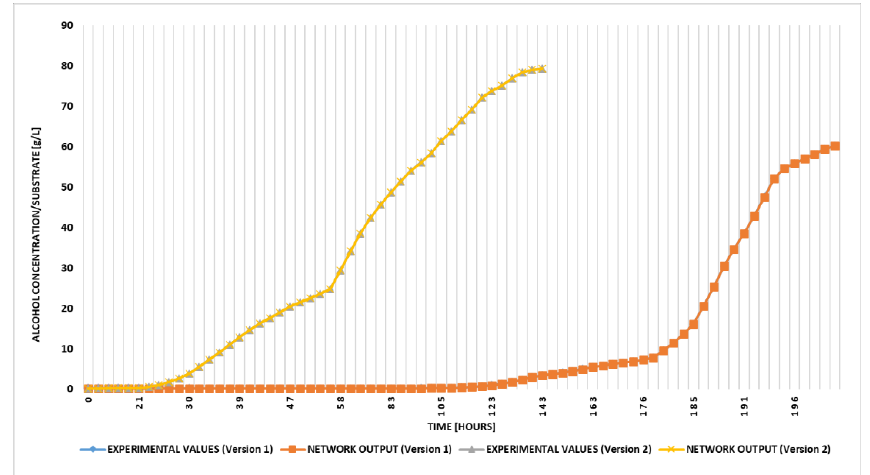
Figure 9. Generated results by the NN vs. experimental values using the first and second variants input-output configurations of NN.